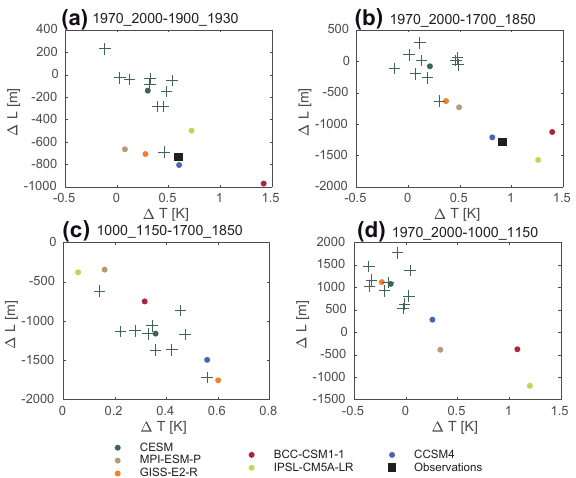
Figure 6. Glacier length changes as a function of summer tempera- ture changes in the Alps for the differences between (a) 1970–2000 and 1900–1930; (b) 1970–2000 and 1700–1850; (c) 1000–1150 and 1700–1850; and (d) 1970–2000 and 1000–1150. For (b) , the aver- age of model results is made only for the glaciers that have observa- tions. The crosses represent the individual CESM ensemble mem- bers, the ensemble mean being represented by a dot of the same